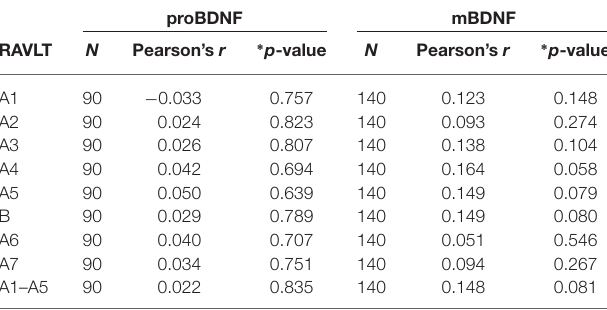
TABLE 5 | Correlations between proBDNF and mBDNF and results of RAVLT. proBDNF mBDNF RAVLT N Pearson’s